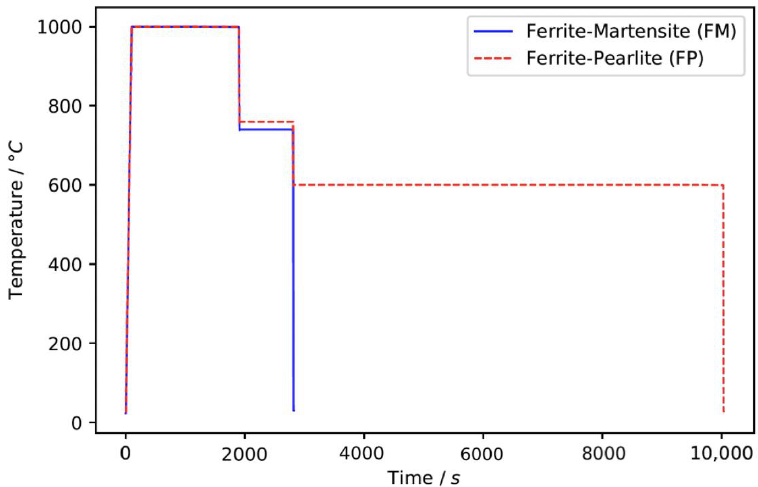
Figure 1. Graphical summary of the heat treatments applied to obtain the different microstruc- tures.